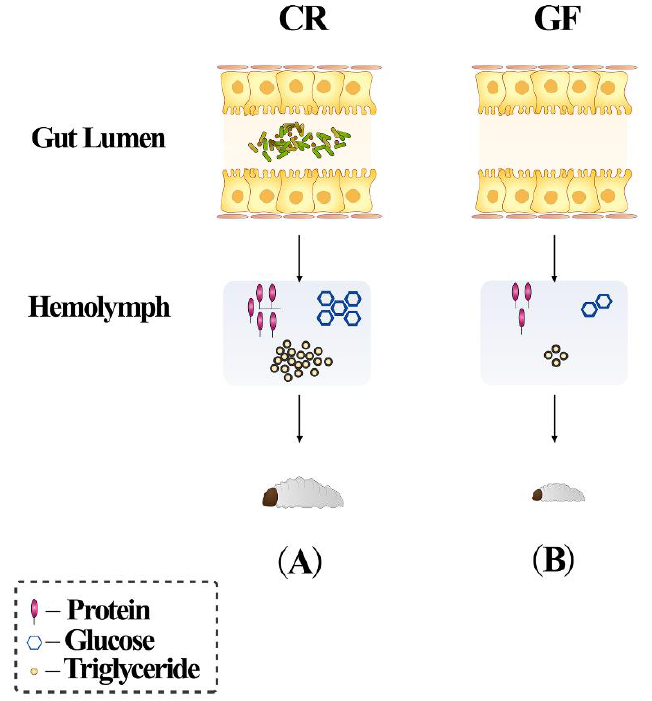
Figure 1. Gut bacteria promote the growth and development of RPW larvae via the modulation of nutrient metabolism. ( A ) The conventionally reared (CR) larvae have higher content of protein, glucose and triglyceride in the hemolymph; ( B ) the body weight, the content of protein, glucose and triglyceride in the hemolymph of germfree (GF) larvae were significantly decreased [41,42].